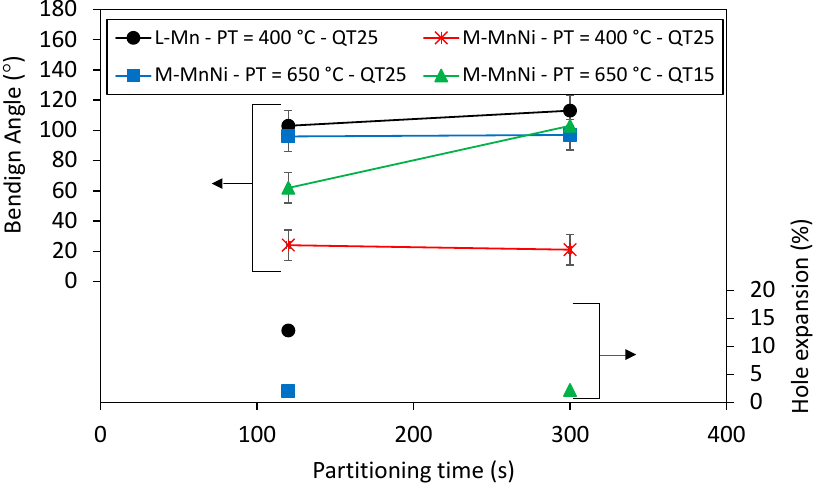
Figure 14. Bending angle as a function of partitioning time after Q&P treatments of L-Mn and M-MnNi steels with different PTs (400 ◦ C and 650 ◦ C) and QTs (QT15 and QT25). Hole expansion results in some of the Q&P conditions in both steels.